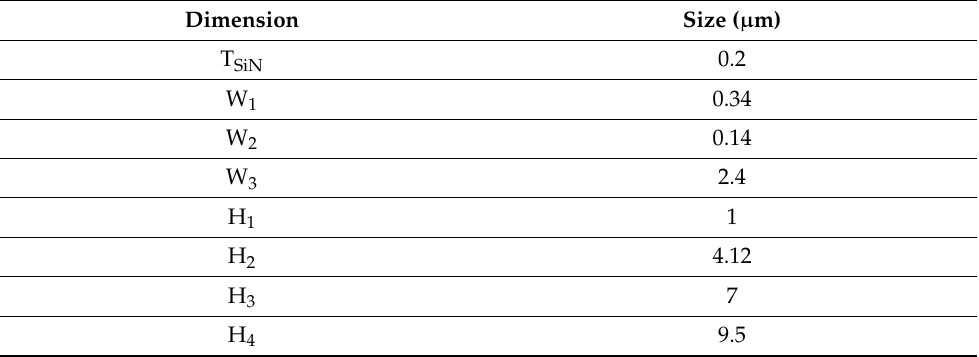
Table 1. Optimized parameters of the designed edge